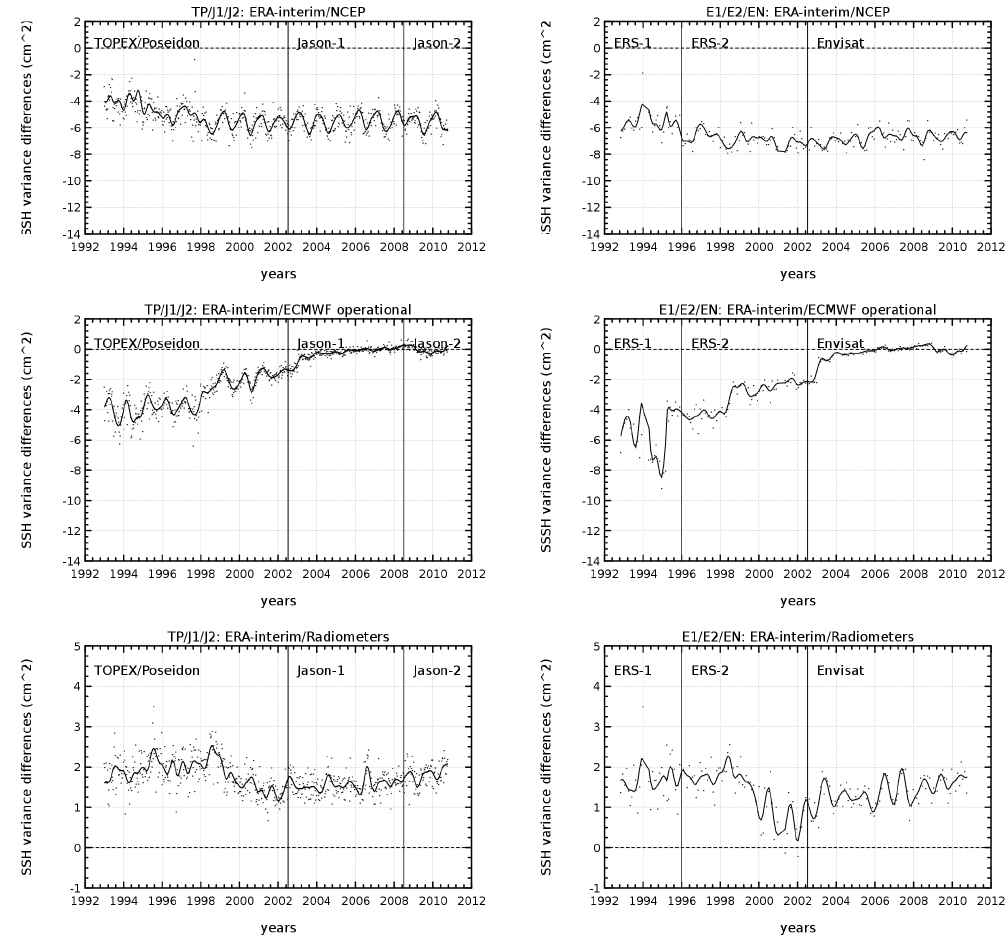
Figure 1. Temporal evolution of sea surface height (SSH) variance differences at crossovers (in cm 2 ) using different wet troposphere corrections successively in the calculation of SSH: ERA-Interim and NCEP/NCAR reanalysis (top), ERA-Interim and ECMWF operational (middle), ERA-Interim and radiometer (bottom). Statistics have been computed with TOPEX/Jason-1/Jason-2 data on the left and ERS-1/ERS-2/Envisat on the right without any selection of the data.